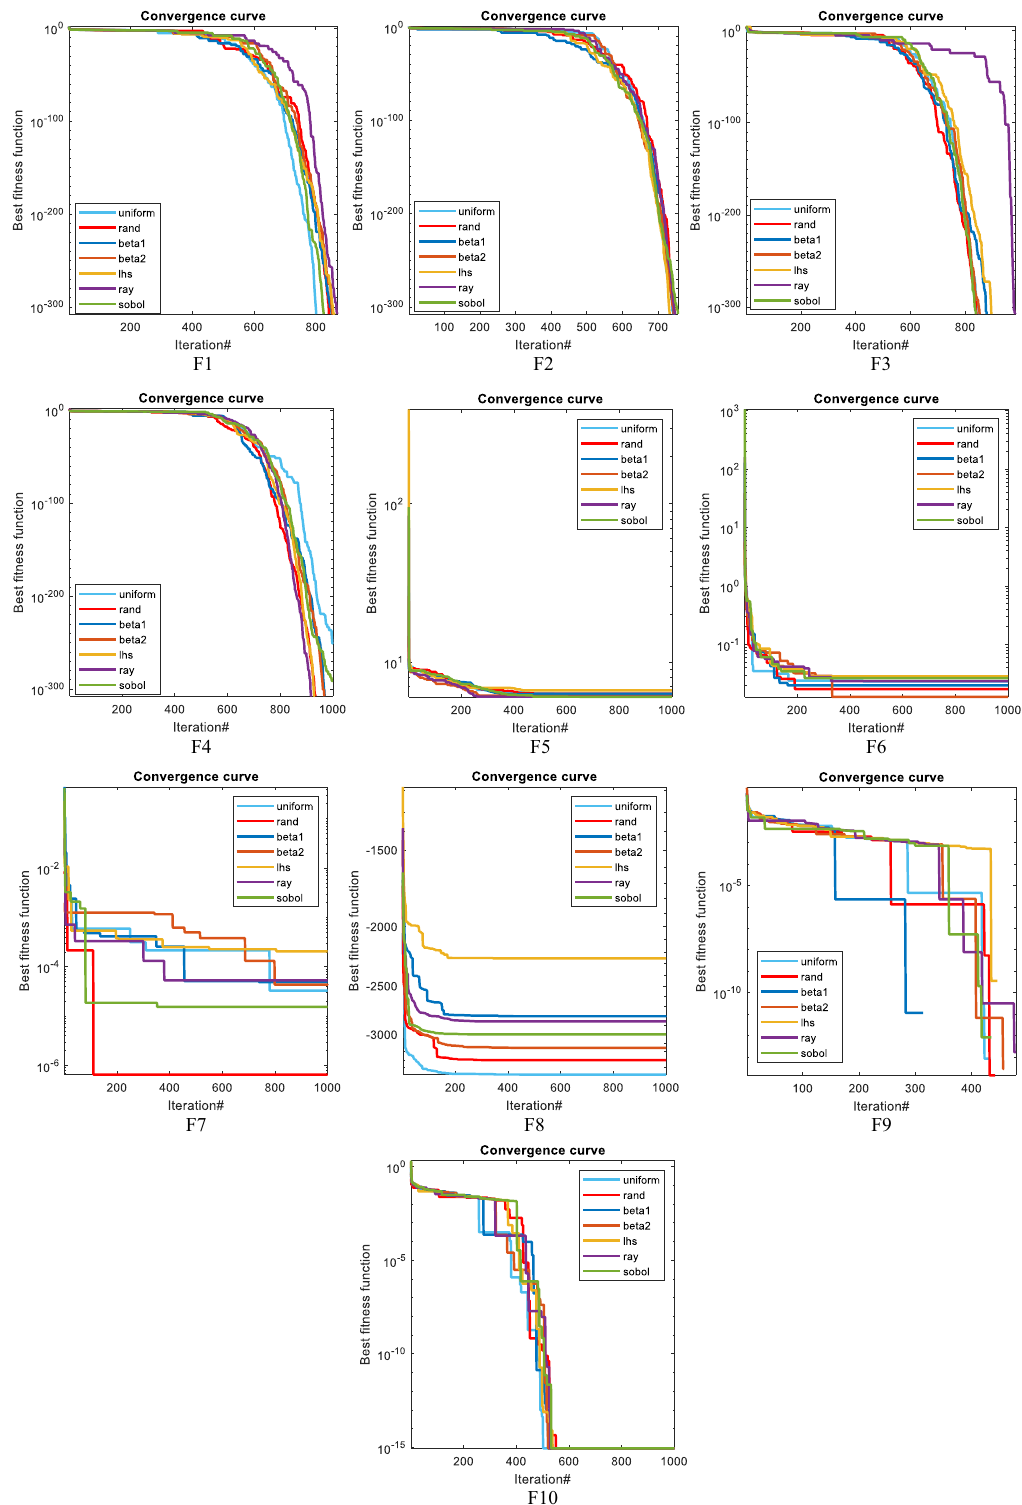
Figure 4: The convergence behavior of AOA variants on classical